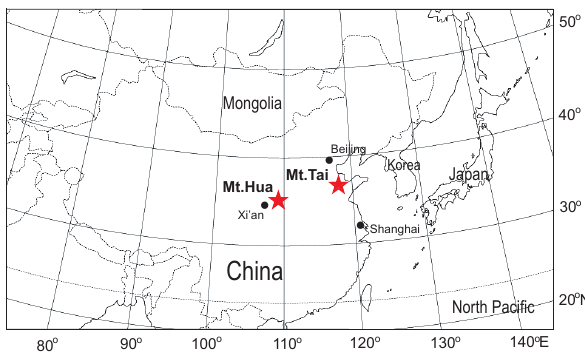
Fig. 1. Sampling sites of Mt. Hua and Mt. Tai in East Asia.